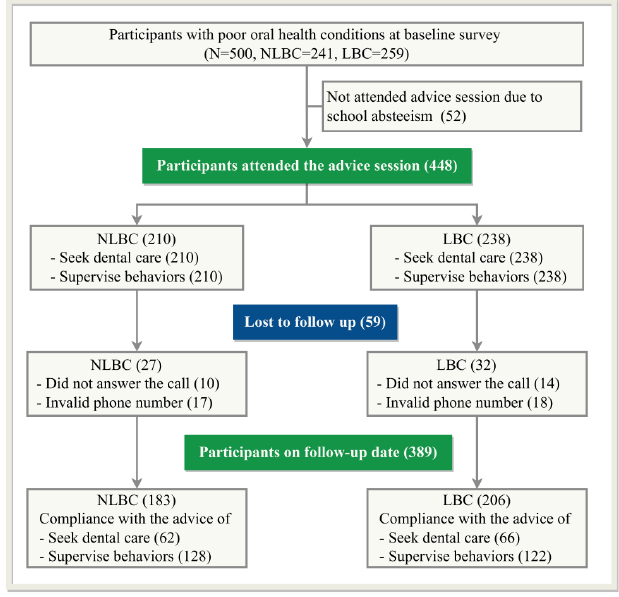
Figure 1. Flow diagram of participation.